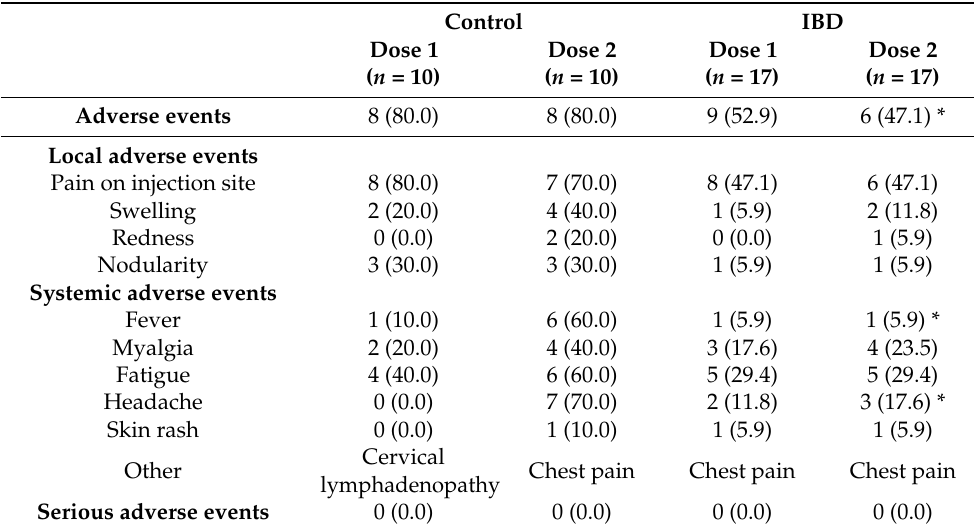
Table 2. Frequency of adverse events after each